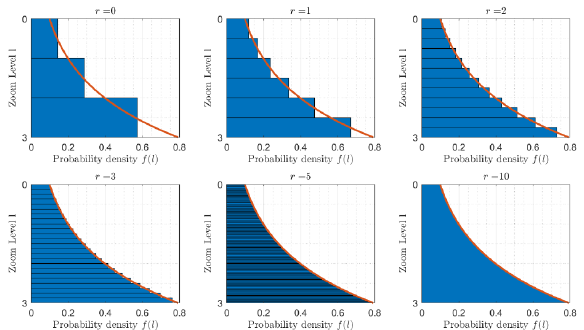
Figure 1. blue bars: refined discrete level-of-detail, red curve: continuous function (Van Oosterom,